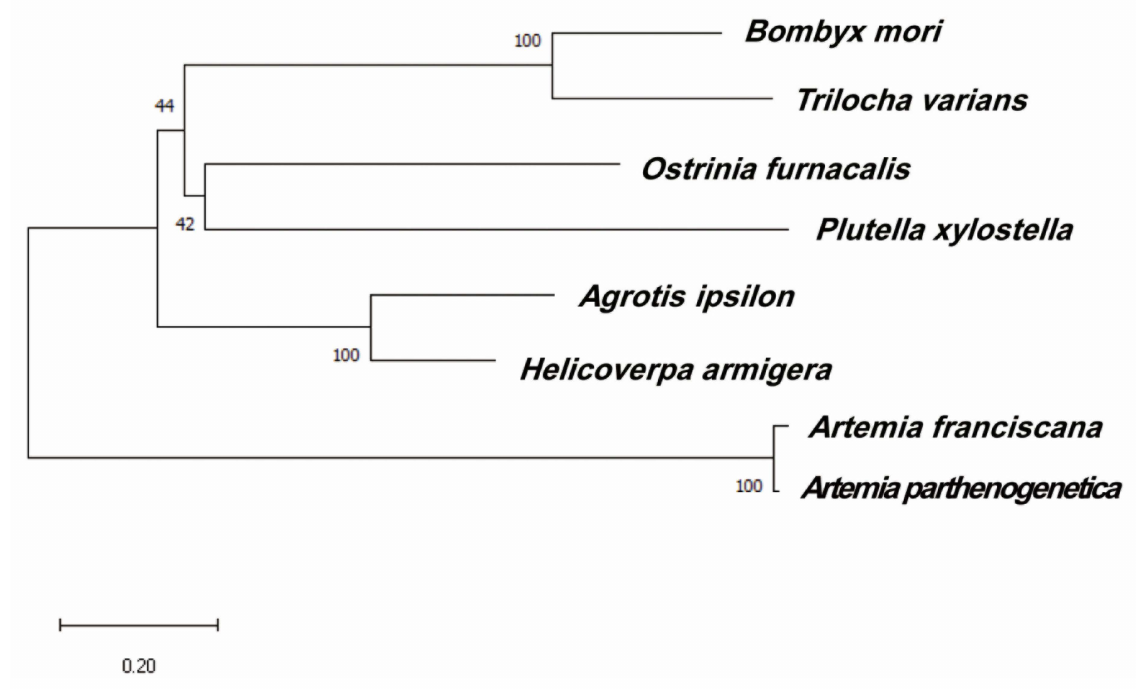
Figure 3. Phylogenetic relationship among known lepidopteran Masc proteins. The neighbor-joining tree of lepidopteran Masc proteins with two brine shrimp ( Artemia species) Masc proteins as the outgroup was drawn with branch length proportional to the inferred amino acid changes. The scale rule for amino acid changes is shown at the bottom. The bootstrap values are shown at the base of each internal